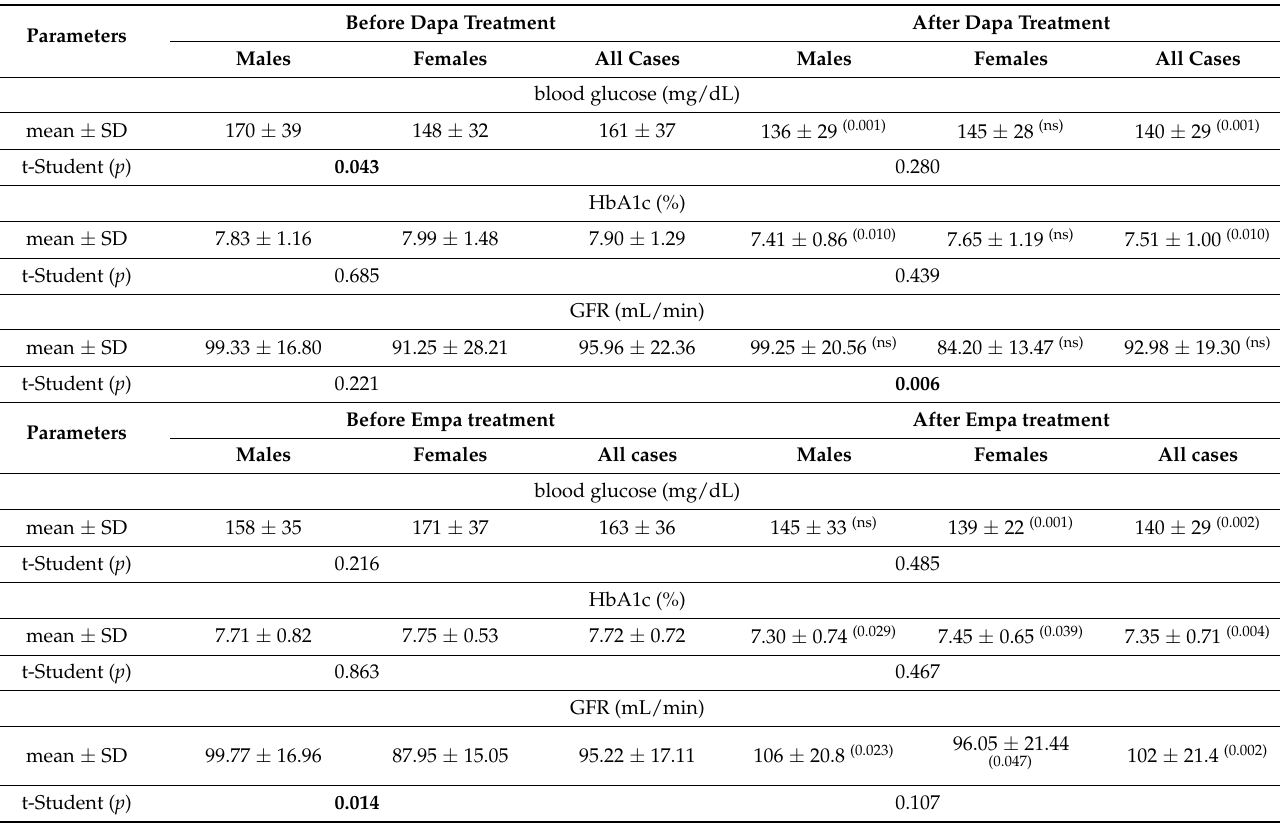
Table 4. Evolution of laboratory parameters after Dapa and Empa treatment,